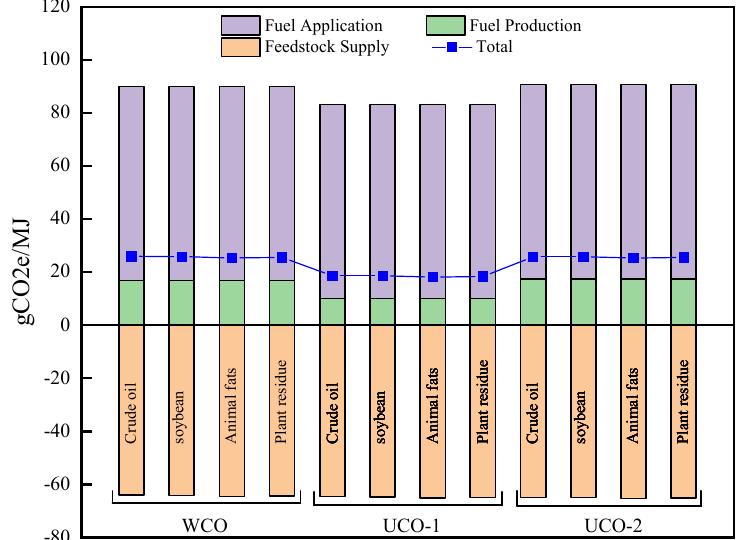
Figure 8. GHG emissions from different diesel sources during their